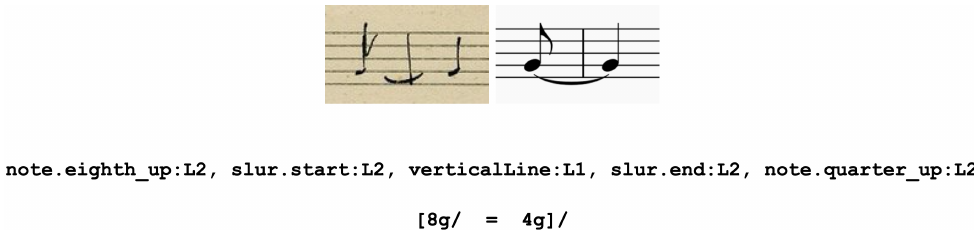
Figure 6. Examples of the translation of slurs and ties. Both original manuscript snapshots and their printed counterparts are shown next to each other. The agnostic encoding and its translation to **kern ∗ are shown below the snapshots. This example shows how the semantic symbols encoding these notes are decorated by adding open and closing brackets to represent the